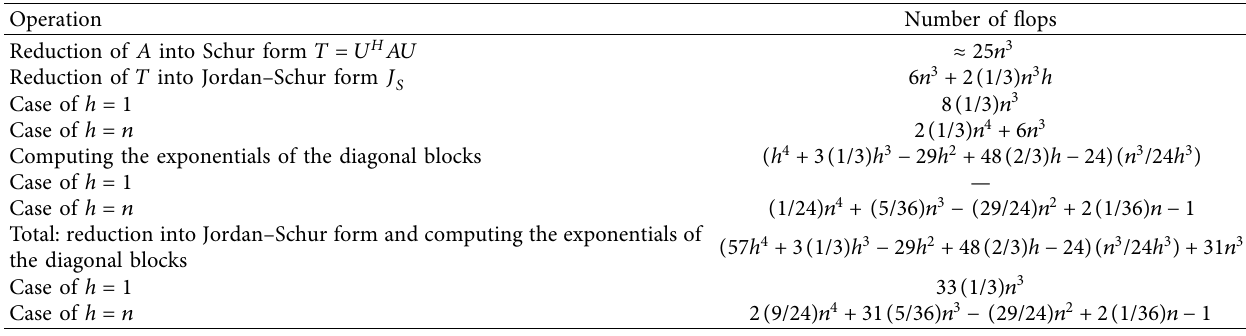
Table 1: Number of computational operations for reduction into Jordan–Schur form and computing the diagonal blocks of the matrix exponential.